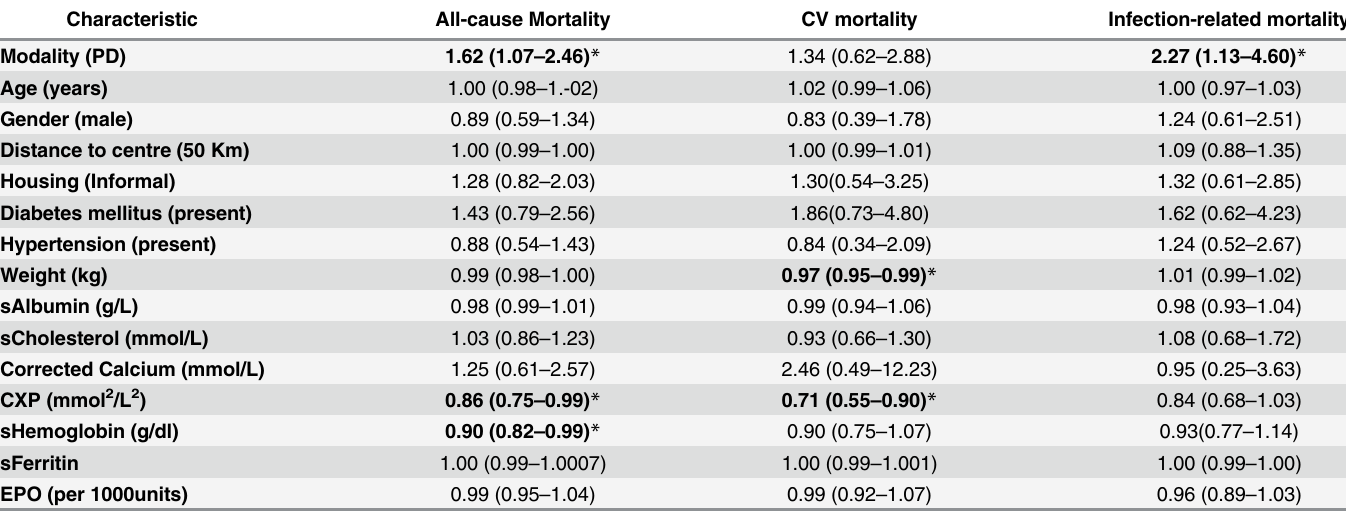
Table 3. Univariate Hazard ratios for all-cause and cause-specific